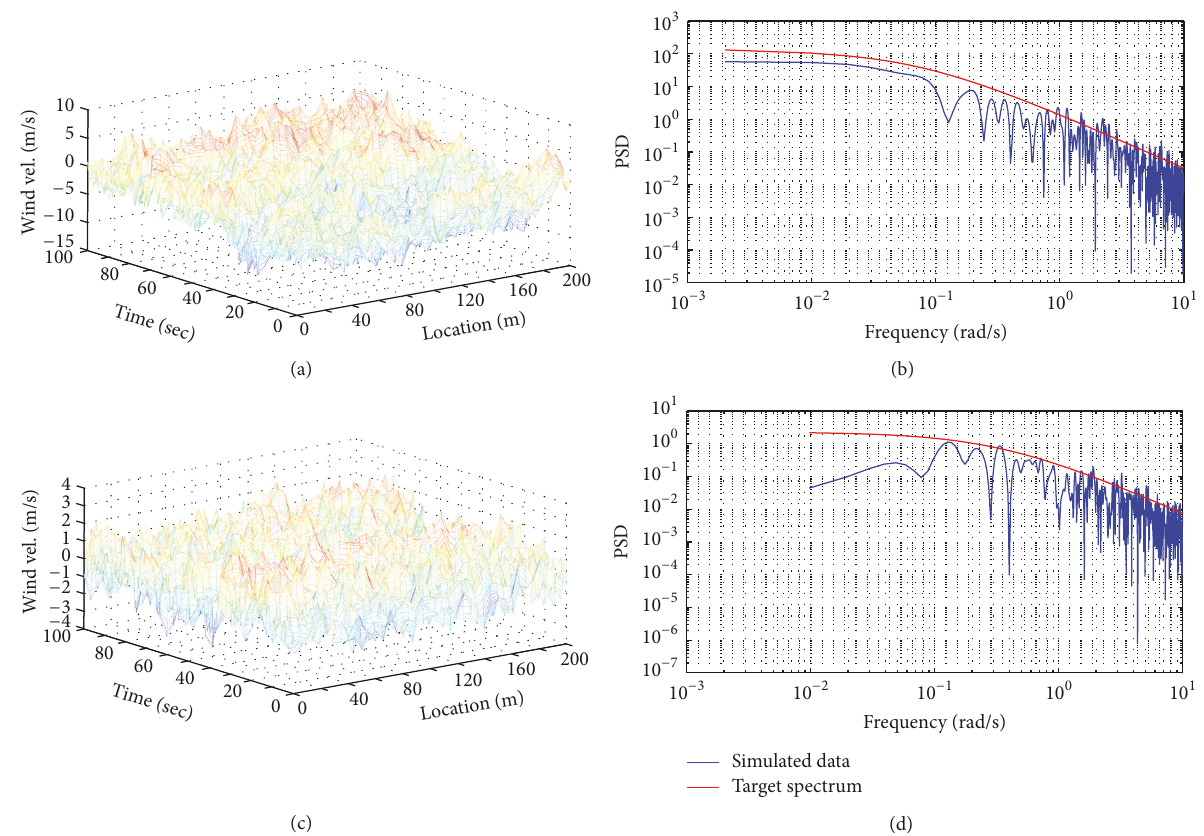
Figure 4: Simulated wind velocities and turbulence spectrum: (a) lateral gust, (b) lateral spectrum, (c) vertical gust, and (d) vertical spectrum.